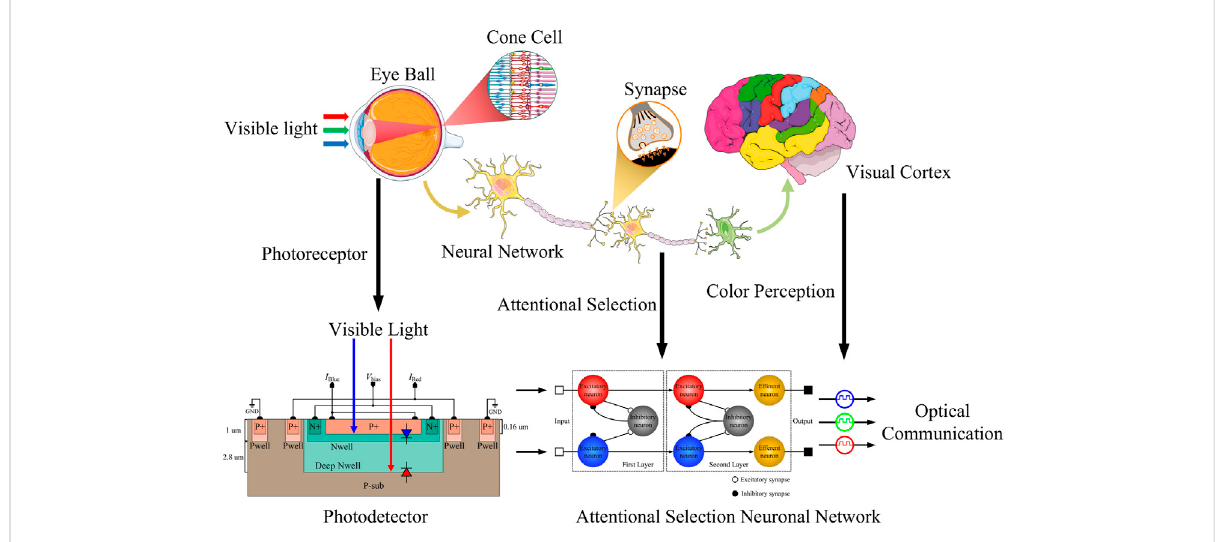
FIGURE 1 The functional diagram of the proposed receiver inspired by visual attentional selection. The optical receiver proposed in this paper can realize the synchronous reception of the red and blue light and the adaptive selection of real-time salient features, and has the autonomy and selectivity similar to that of human beings